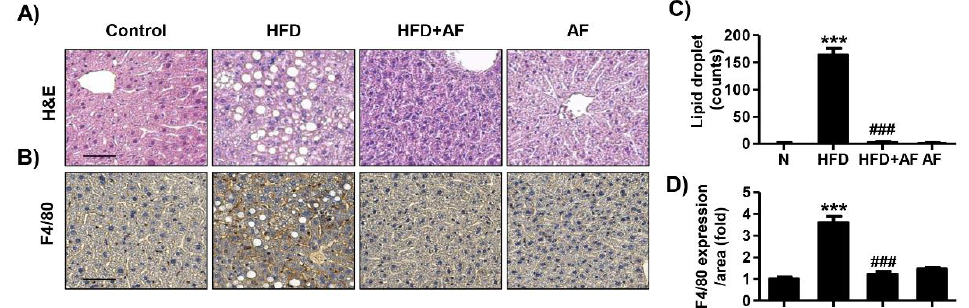
Figure 3. Auranofin alters morphological changes and macrophage infiltration in the liver of the HFD-induced NALFD mouse model. ( A ) The histological changes were assessed by H&E staining. Scale bar—50 μm. ( B ) The expressions of F4/80 were evaluated by immunohistochemistry (IHC) using specific antibodies. Representative images of F4/80-positive cells. Scale bar—50 μm. ( C ) The lipid droplets per area were counted and expressed in graph. ( D ) Quantification of the F4/80 expression in area. Data are expressed as means ± SD ( n = 3). *** p < 0.001 compared with the normal group. ### p < 0.001 compared with HFD group. N, normal group; HFD, HFD fed group; HFD + AF, HFD fed and auranofin injection group; AF, auranofin injection group.